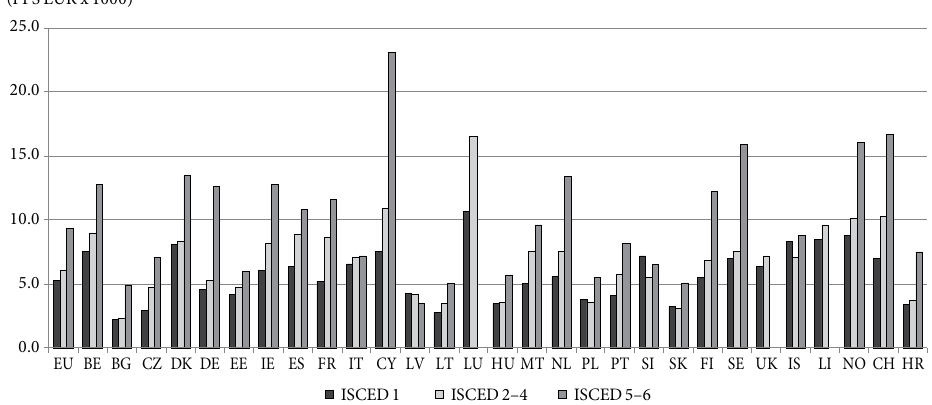
Fig. 1. Annual expenditure in public institutions per pupil/student and educational level (ISCED 1, 2–4 and 5–6), in PPS EUR (thousands), 2008 Source : Eurostat, UOE and national accounts statistics (data extracted June